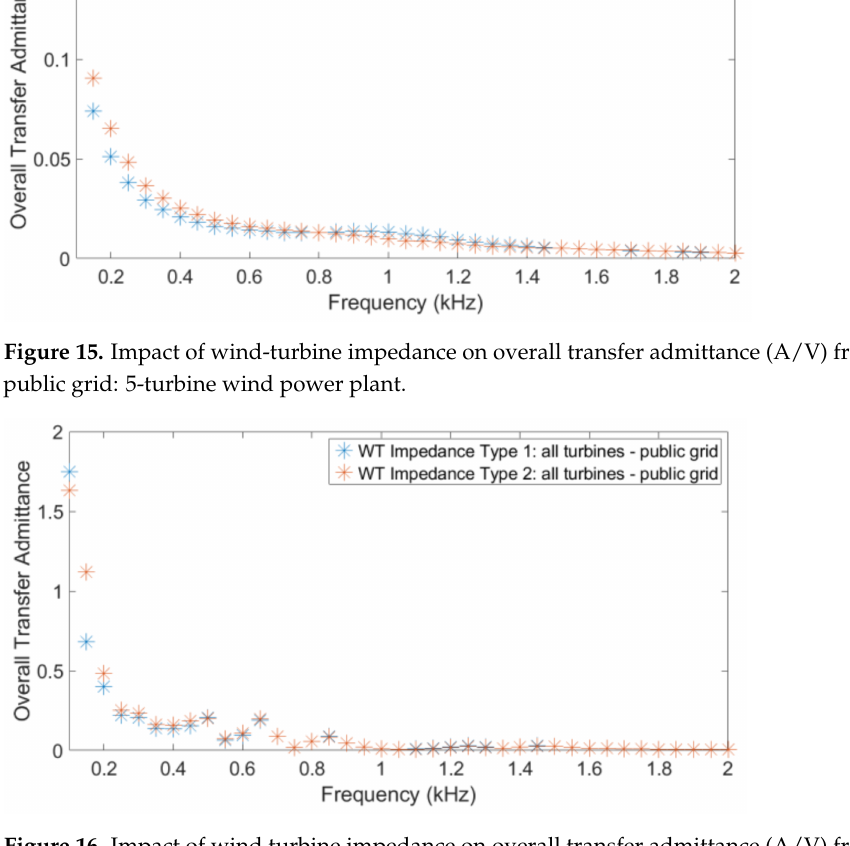
Figure 16. Impact of wind turbine impedance on overall transfer admittance (A/V) from turbine to public grid: 42-turbine wind power